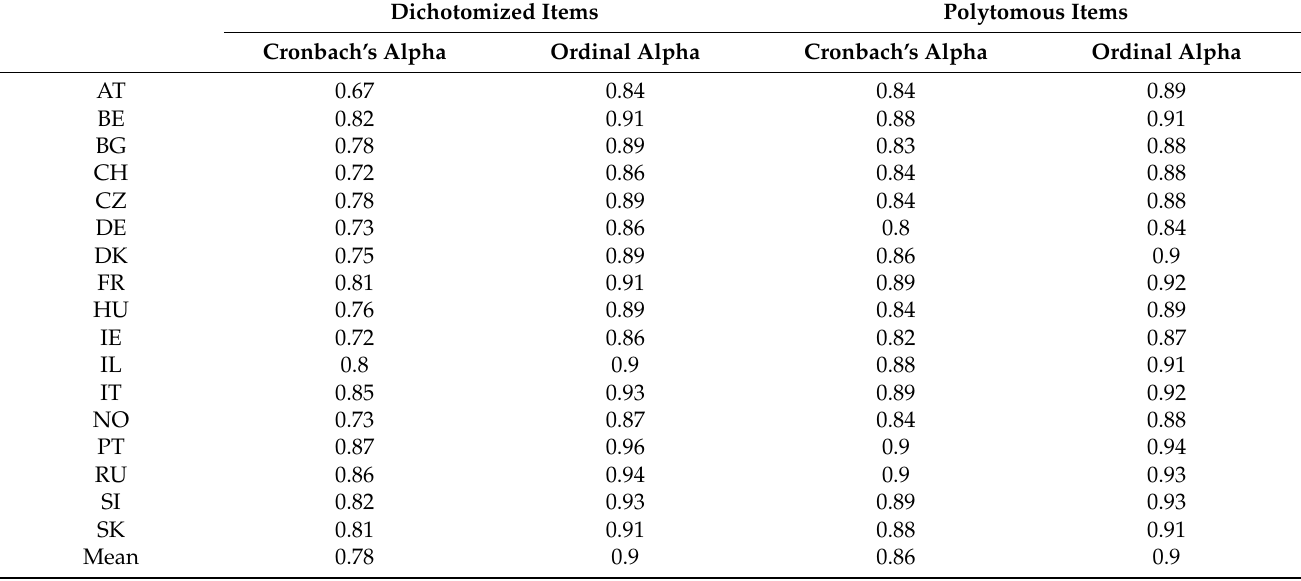
Table 3. Cronbach’s alpha and ordinal alpha for the HLS 19 -Q12 (polytomous and dichotomized items) for each country, and the mean for all countries (equally